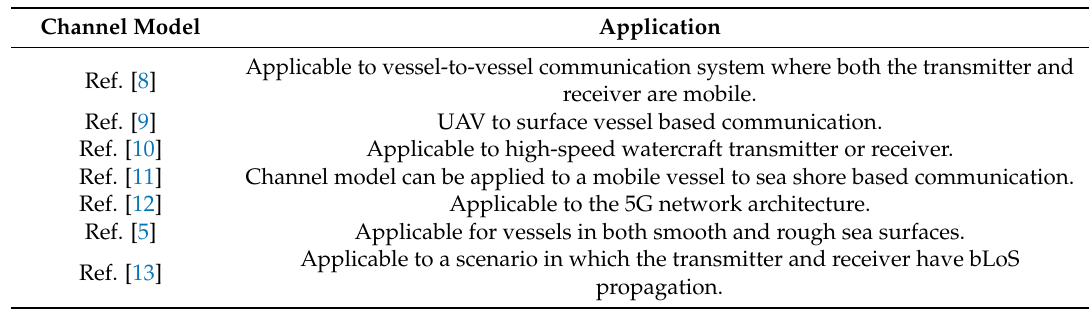
Table 4. Applications of the channel